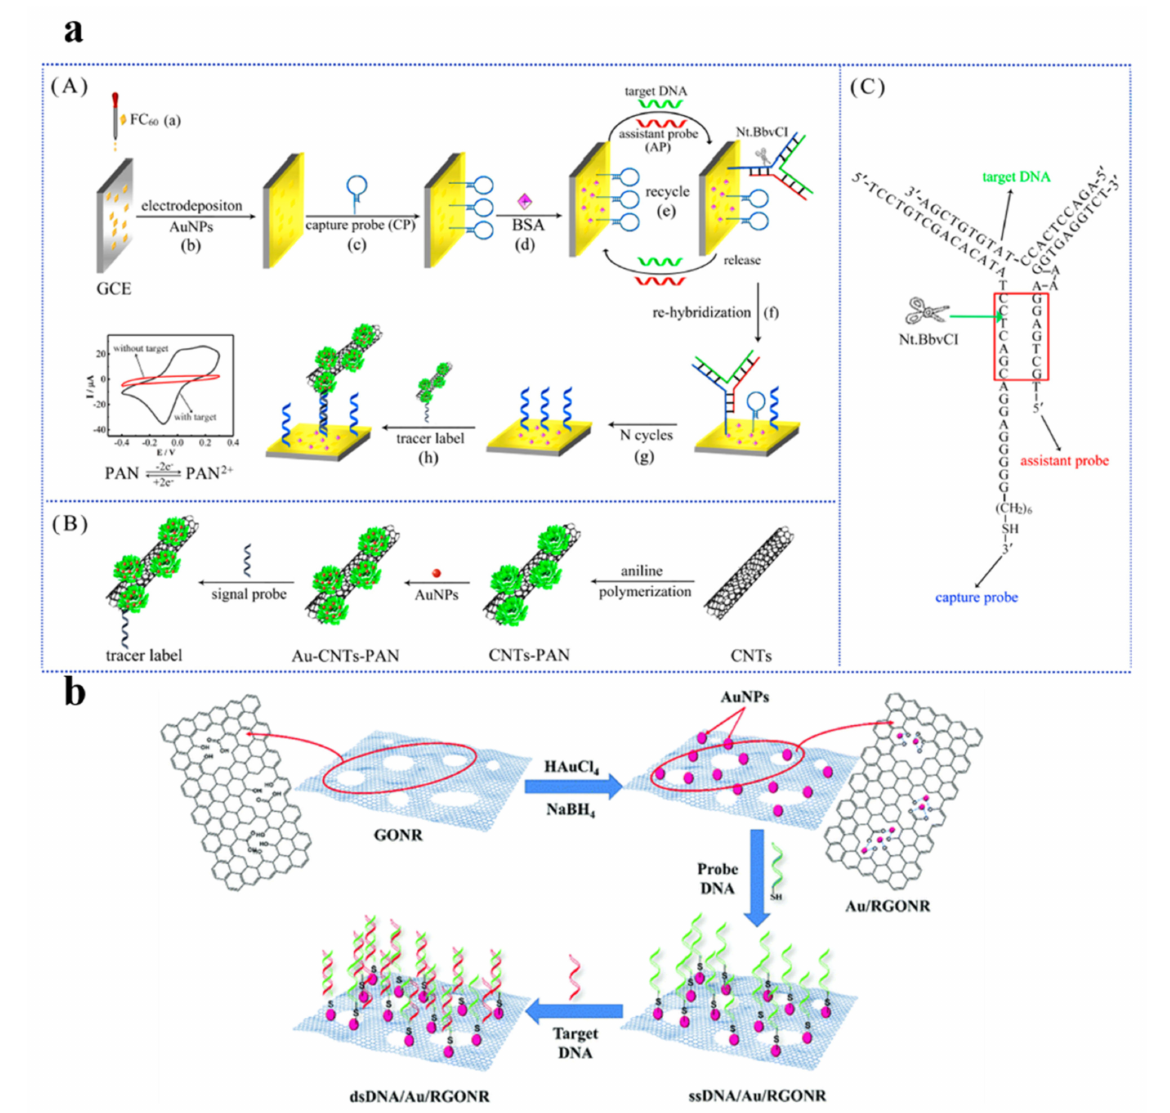
Figure 5. Schematic illustration of electrochemical biosensors fabricated with carbon nanomaterials for detection of Mycobacterium tuberculosis : ( a ) biosensor fabricated with carbon nanotubes doped with flower-like polyaniline (CNTs-PAN) nanohybrid structure and Y-shaped three-way DNA junc- tion structure for detection of the specific IS6110 DNA sequence of Mycobacterium tuberculosis [18]; ( b ) biosensor fabricated with gold nanoparticles (AuNPs) immobilized over reduced graphene